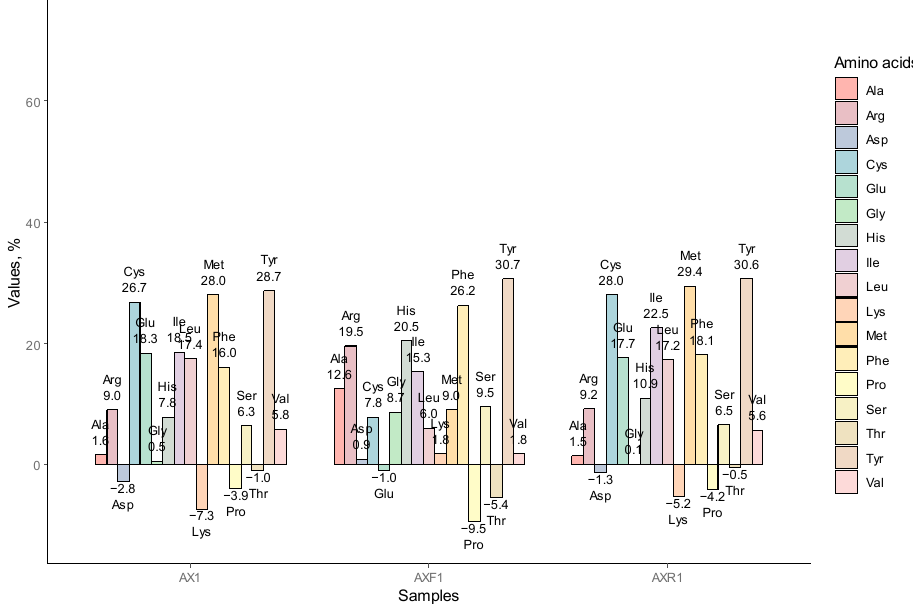
Figure 3. The percentage change of amino acid amount in samples AX1, AXF1, AXR1, compared to initial oat material, oat flakes (FL1). Apparently, the ionic shift does not promote the aggregation of various protein sub- units; rather, the changed ionic charge stimulates protein aggregation, attracting proteins of the same fraction, or changes to forms disposed to faster sedimentation. On the other hand, the presence of xylanase during hydrolysis changes the concentration of AAs in the fiber stream considerably.